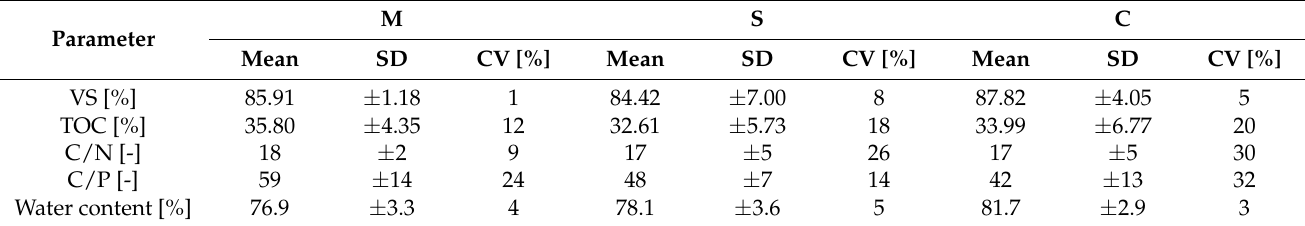
Table 1. Mean values of the tested SS-OFMSW parameters from multi-family (M) and single-family housing (S) and catering